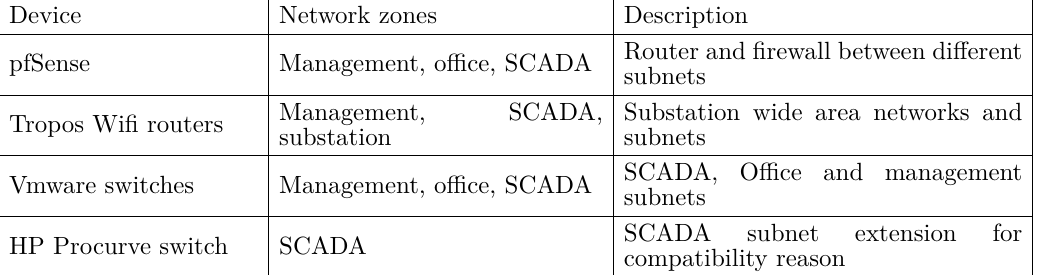
Table 5. Network devices in the SCADA